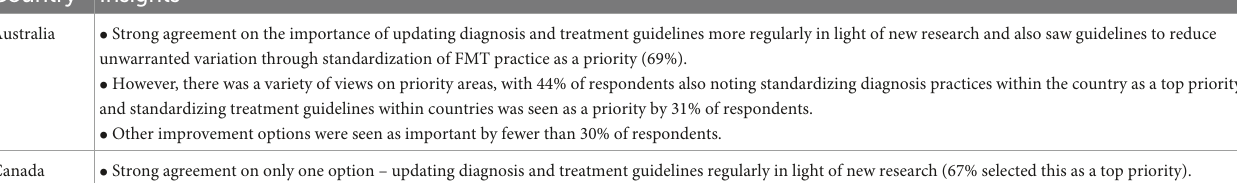
TABLE 6 Country-level insights relating to guideline and regulation priorities. Country Insights